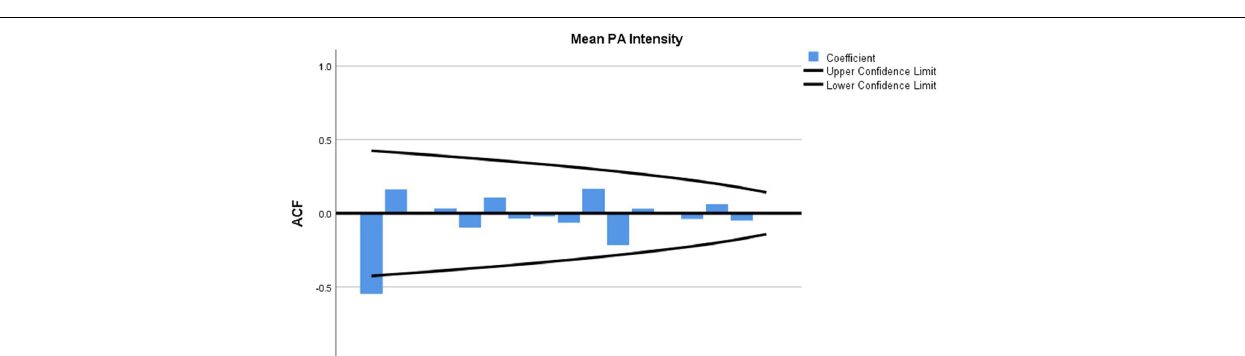
FIGURE 4 | Project move SMART conceptual model.